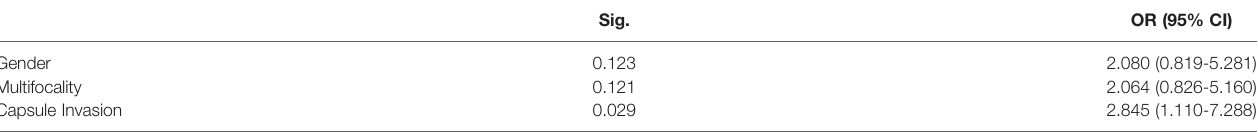
TABLE 4 | Multivariate analysis of the risk factors of PTMC.